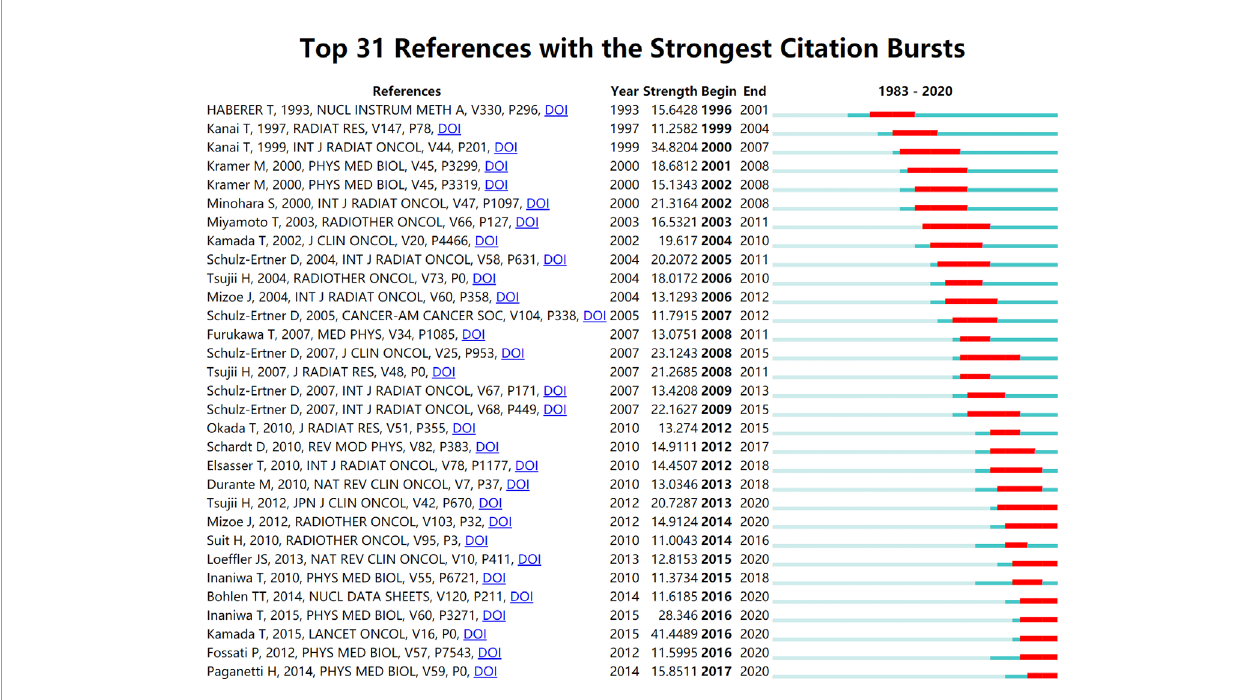
FIGURE 6 | Burst articles of HIRT-related